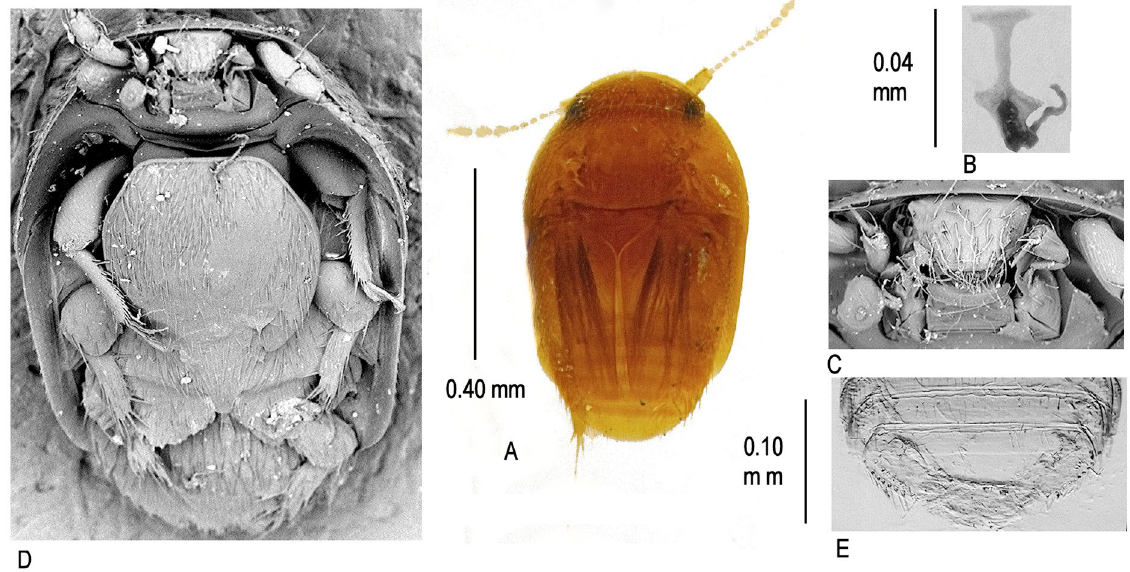
Fig. 11. Kuschelidium sarawakense sp. nov. A . Dorsal habitus. B . Spermatheca. C . Head ×695. D . Ventral habitus ×370. E .